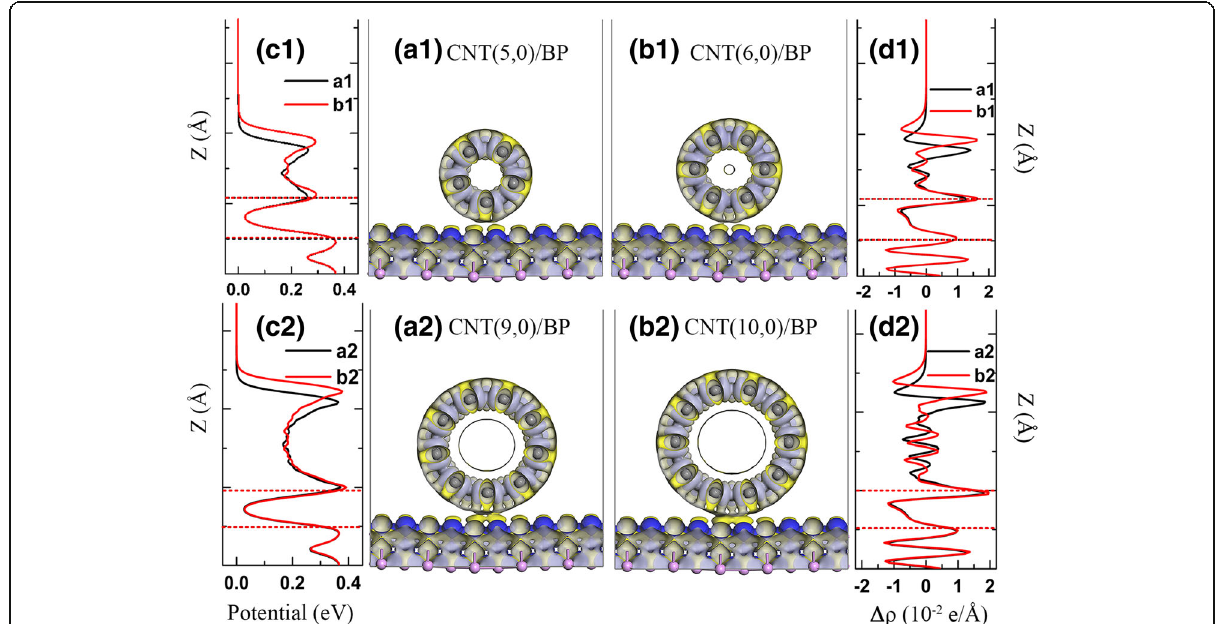
Fig. 5 3D Charge density differences for ( a1 ) CNT(5,0)/BP, ( b1 ) CNT(6,0)/BP, ( a2 ) CNT(9,0)/BP, and ( b2 ) CNT(10,0)/BP. The yellow and blue represent charge accumulation and depletion, respectively; the isovalue is 0.0015 e/Å 3 ( c1 ). ( c2 ) Profile of the planar averaged self-consistent electrostatic potential for the ( a1 ) CNT(5,0)/BP, ( b1 ) CNT(6,0)/BP, ( a2 ) CNT(9,0)/BP, and ( b2 ) CNT(10,0)/BP as a function of position in the z- direction. ( d1 ), ( d2 ) Profile of the planar averaged charge density difference for the ( a1 ) CNT(5,0)/BP, ( b1 ) CNT(6,0)/BP, ( a2 ) CNT(9,0)/BP, and ( b2 ) CNT(10,0)/BP as a function of position in the z-direction. The horizontal dashed line is the position of both the bottom layer of the CNT surface and the top p atom in monolayer